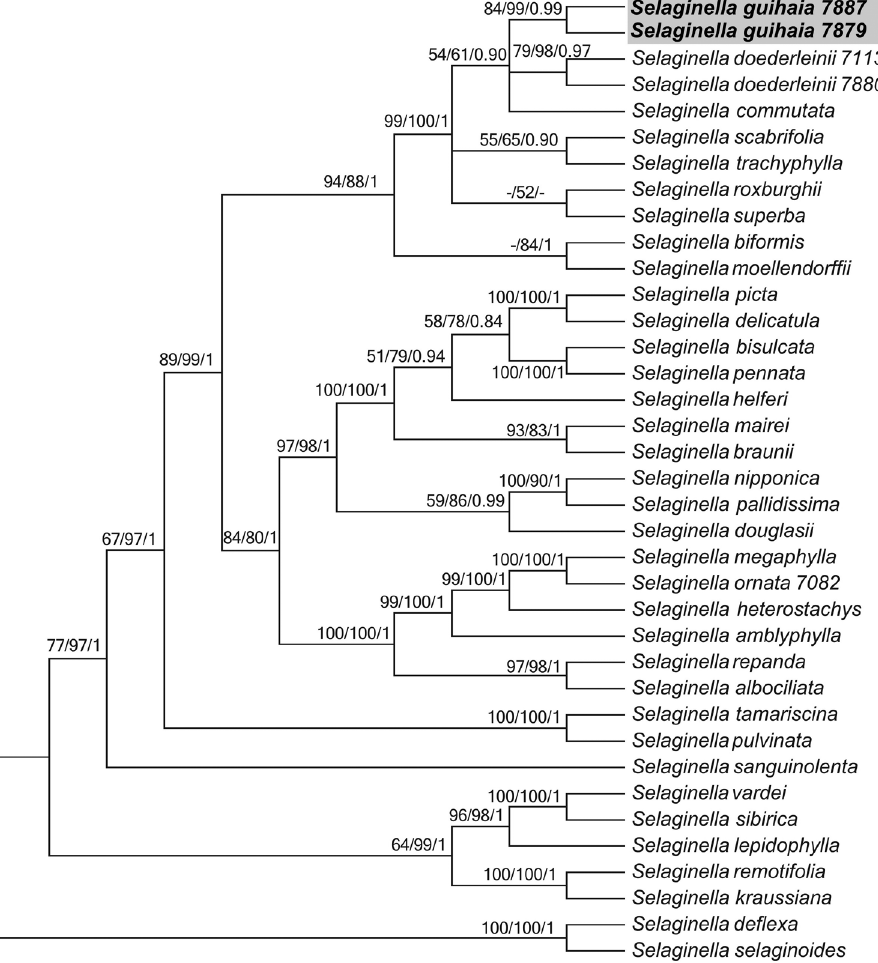
, ML > 50%, BI > 0.8) are shown above the main braches; BS BS PP